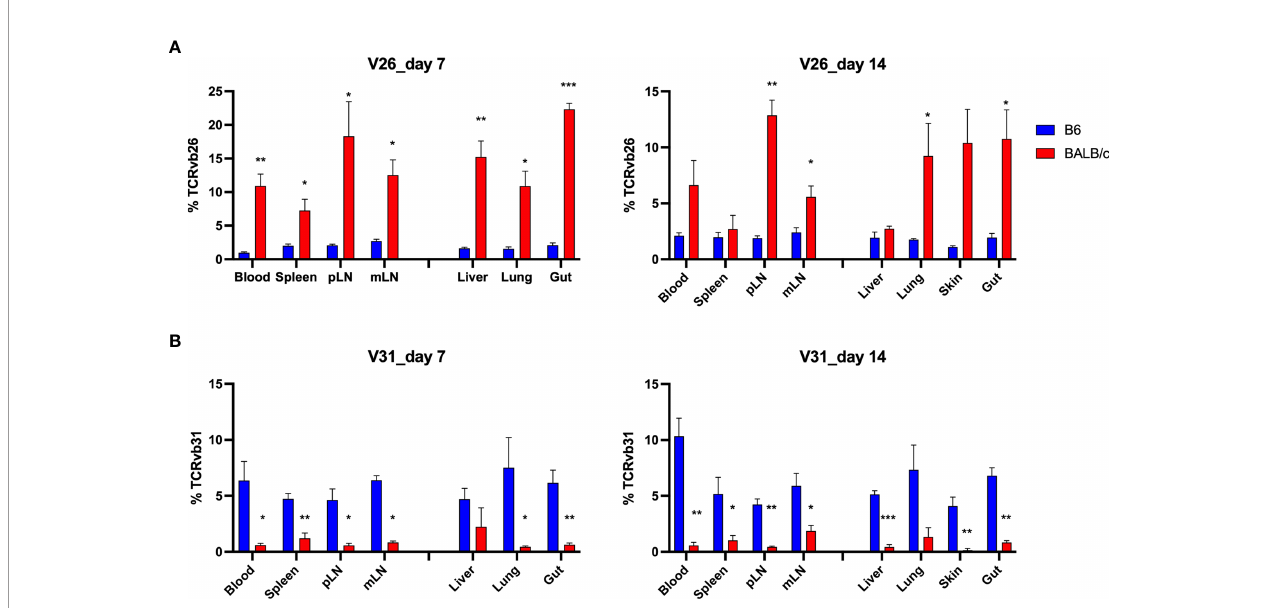
FIGURE 7 | Distinct V gene usage pattern in allogeneic vs. syngeneic T cells. Frequency of V genes in total counts were analyzed in different tissues. Pooled data of V26 and V31 gene frequency are shown in the bar graph (A, B) . *p < 0.05, **p < 0.01, ***p <